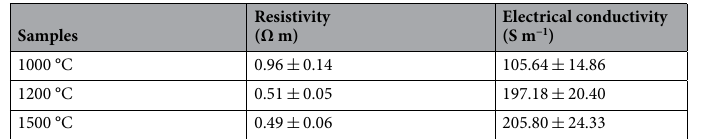
Table 1. Electrical properties of the carbonised ASL-ESL lignin fibres that were carbonised in nitrogen at 1000 °C, 1200 °C and 1500 °C for 1 h.